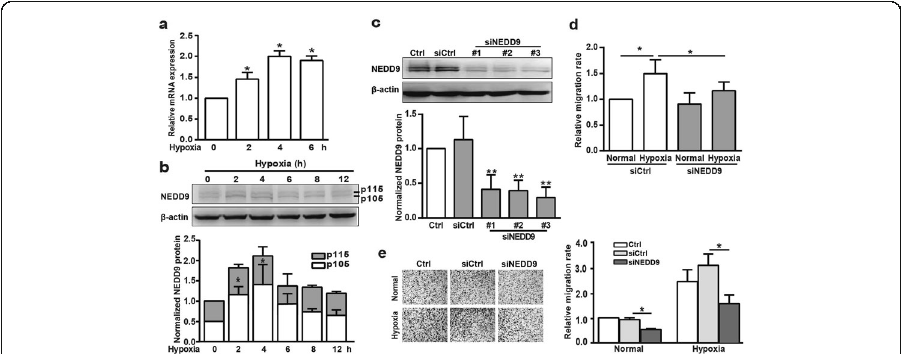
Fig. 2 Effect of NEDD9 on hypoxia-induced breast cancer cell migration. ( a & b ) MDA-MB-231 cells were subjected to hypoxia for the indicated time and the NEDD9 mRNA or protein levels were determined